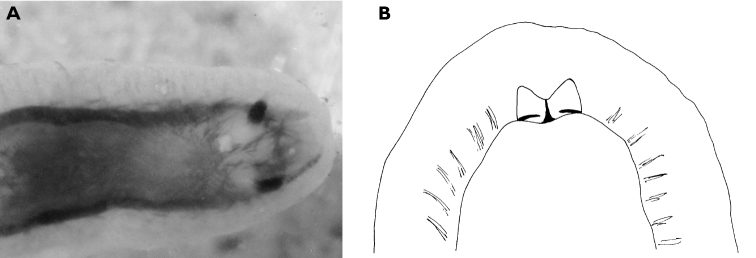
Phyllidiella rudmani, juvenile 10 mm specimen A dorsal view showing black markings, lack of tubercles, and spicule arrangement B ventral view showing propodium, head, and oral tentacles.